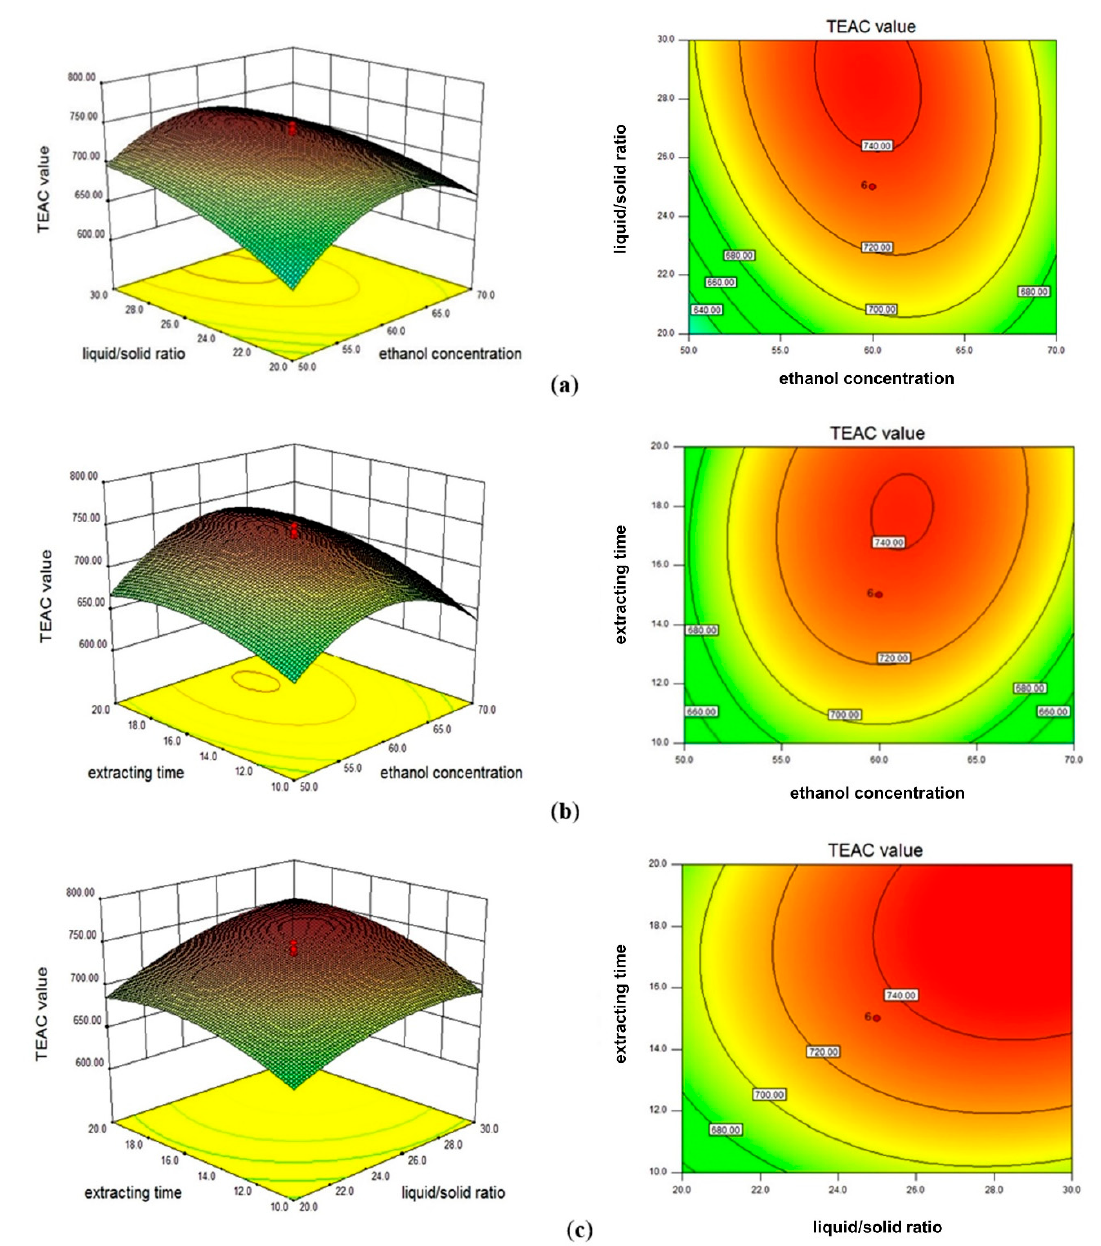
Figure 2. Response surface analysis showing the interactive e ff ects of parameters, including ( a ) LS ratio and ethanol concentration, ( b ) extraction time and ethanol concentration, and ( c ) extraction time and LS ratio, on the TEAC values.